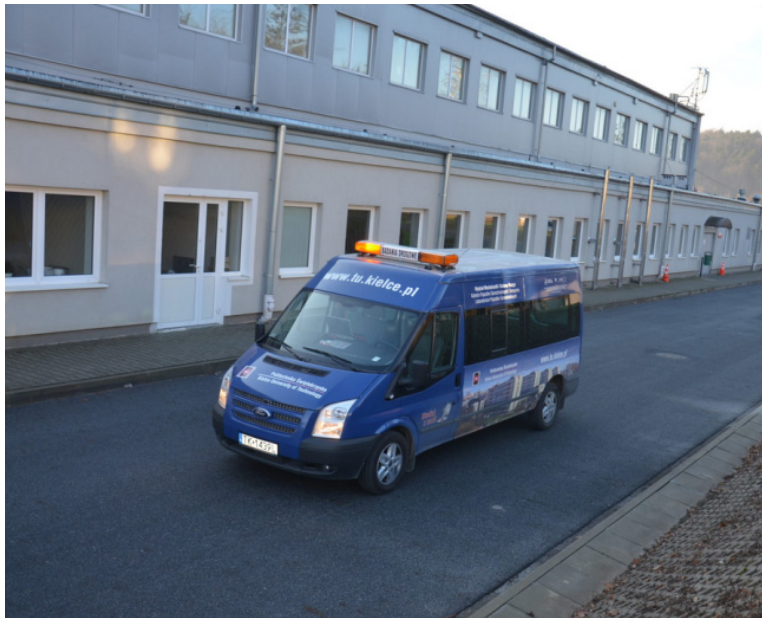
Figure 1. Ford Transit test vehicle.